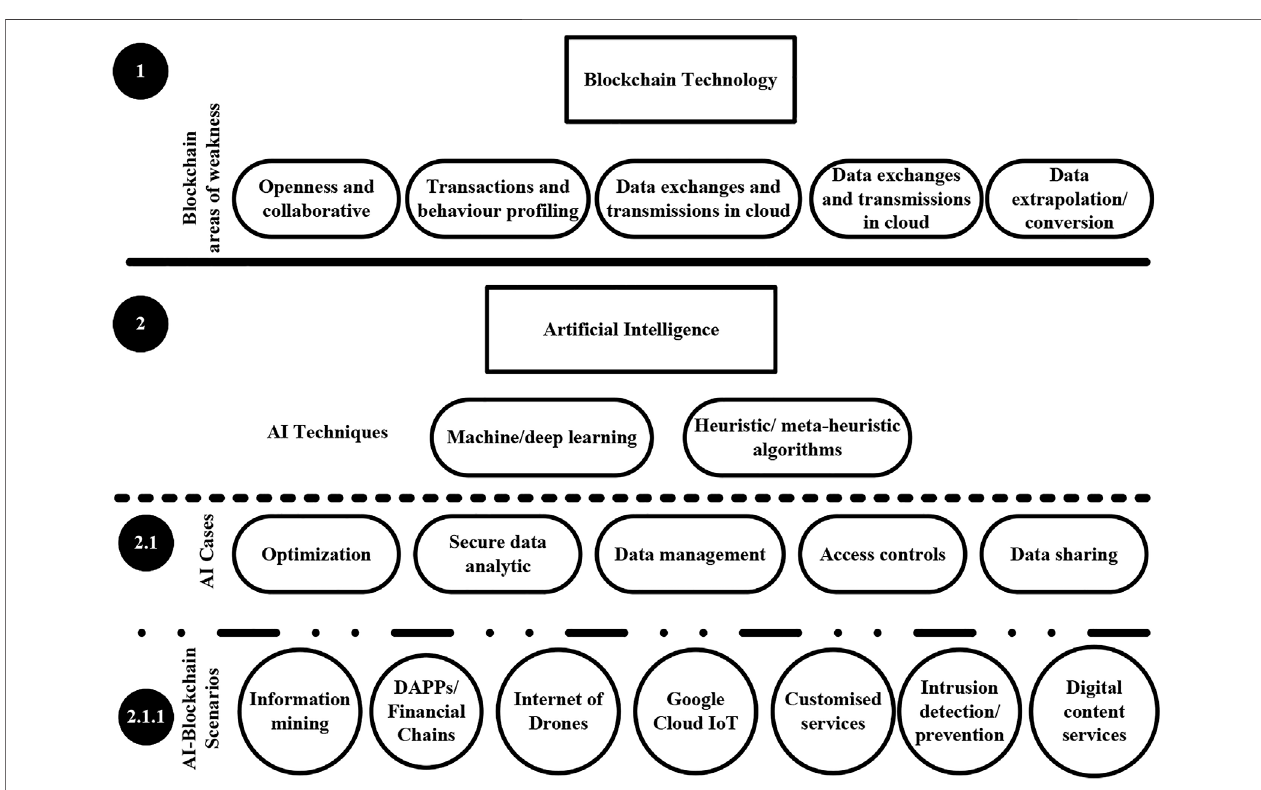
FIGURE 1 | Hierarchy of the cases and scenarios of AI in blockchain technology.